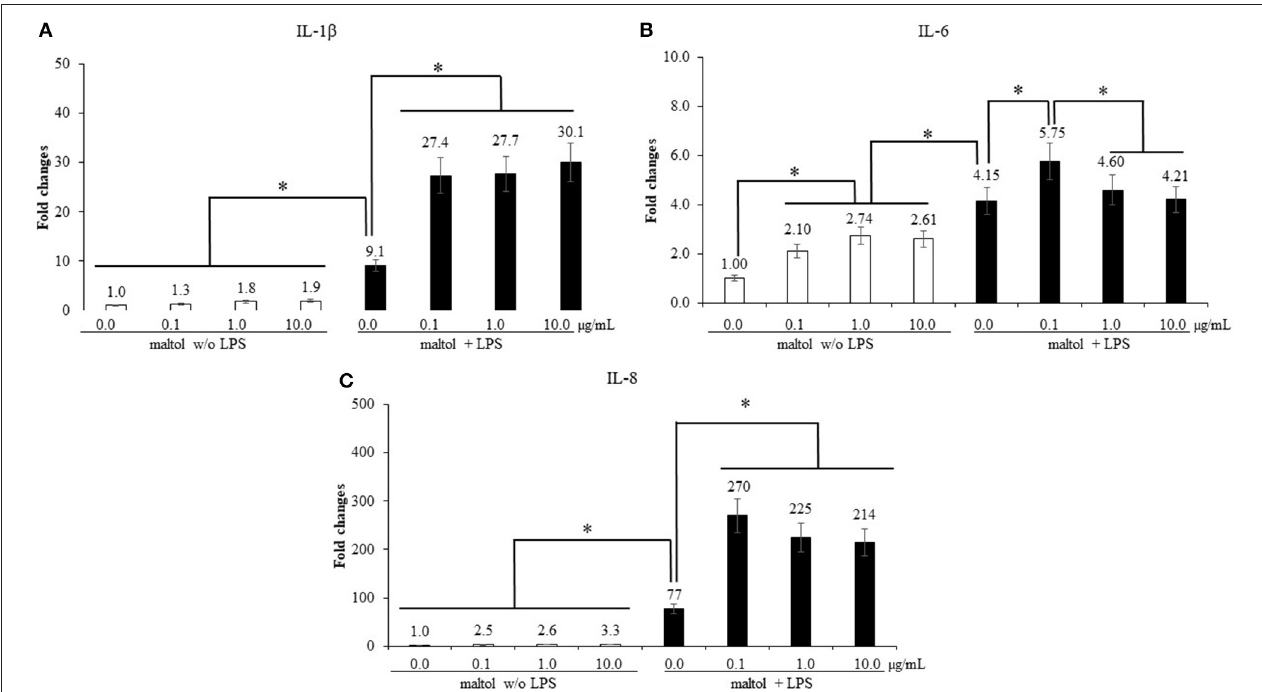
FIGURE 4 | Secretion of pro-inflammatory cytokines in chicken macrophages (CMC) by LPS and maltol. Each bar represents the mean ± SEM ( n = 3). Transcript levels of the cytokines were measured using quantitative RT-PCR and normalized to GAPDH transcript levels. Significant results are marked as * ( P < 0.05). LPS,